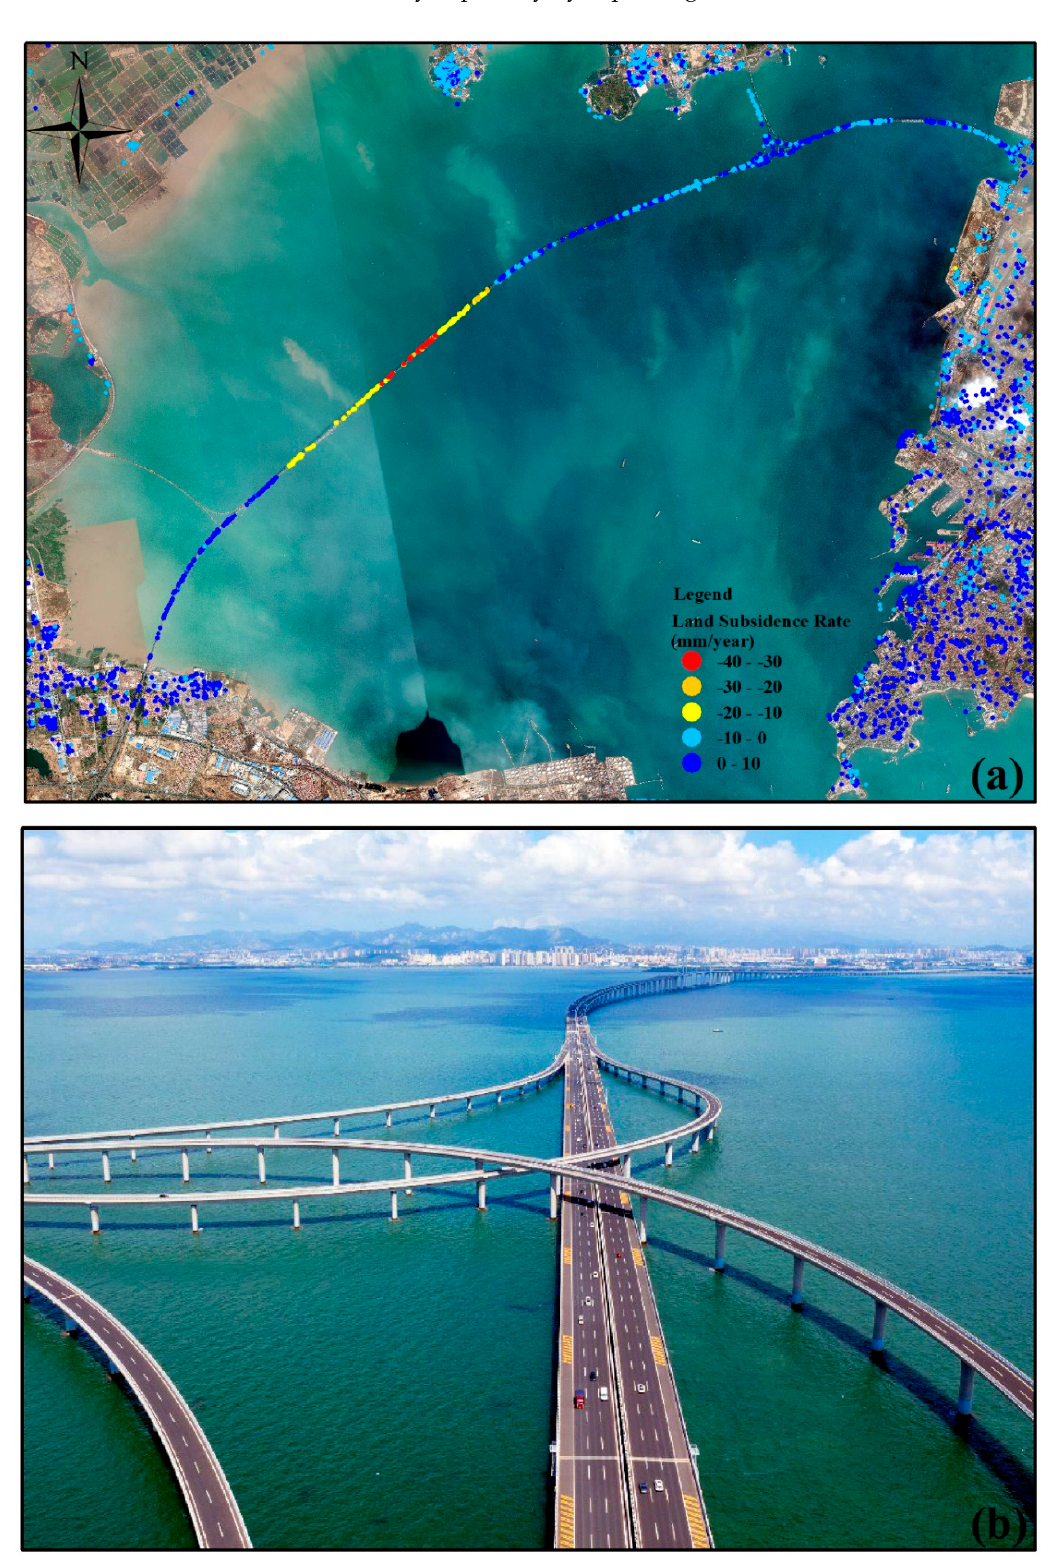
Figure 14. The land subsidence of Jiaozhou Bay Bridge (JBB). ( a ) A remote sensing image of JBB; ( b ) a photo of JBB.